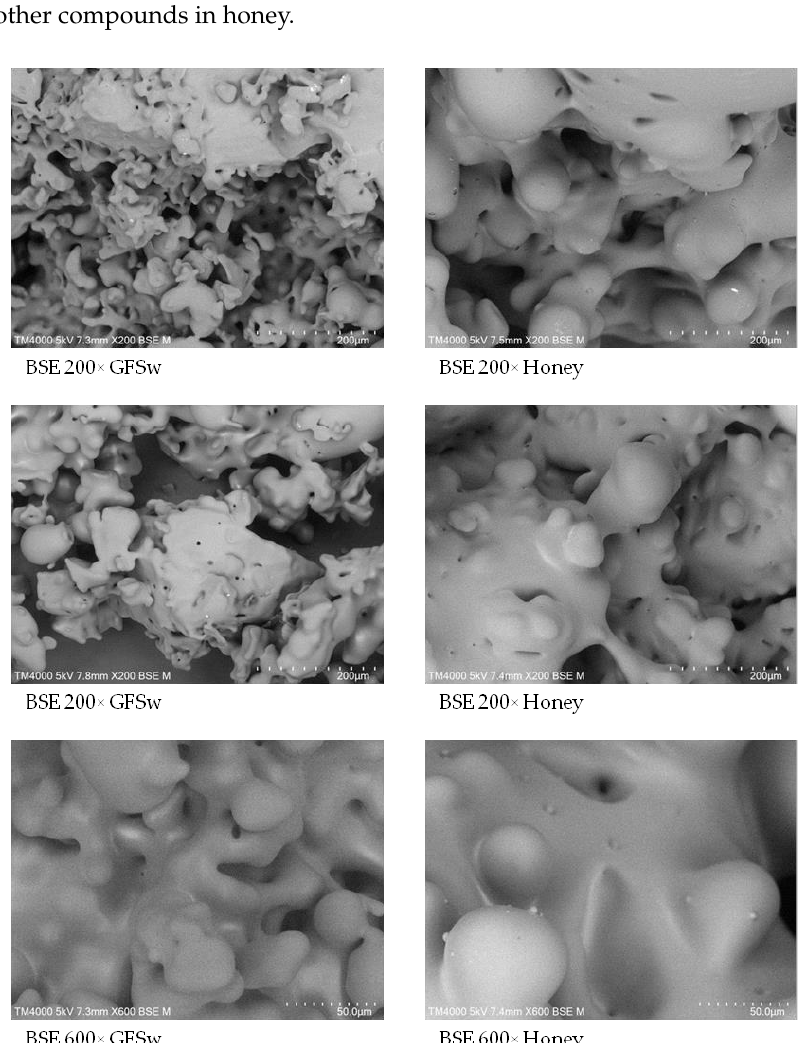
Figure 7. SEM micrographs of spray-dried honey and GFSw at 200× and 600× magnification. The XRD profiles show two wide main peaks and a much less intense one, similar to honey and GFSw (Figure